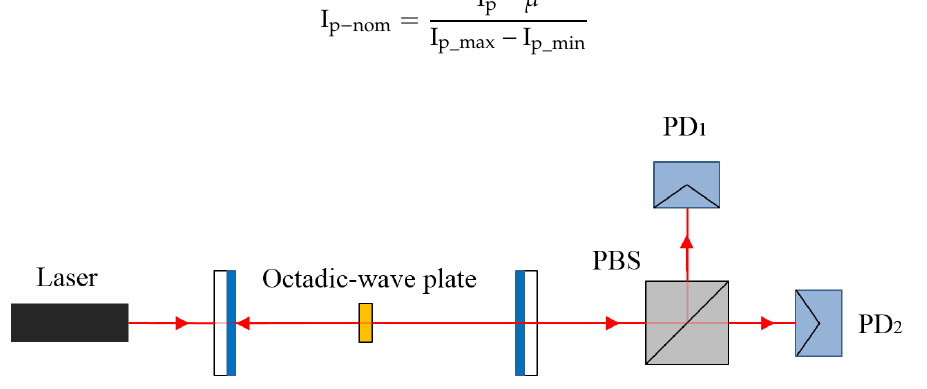
Figure 2. The optical arrangement of polarized Fabry–Pérot interferometer. PBS, polarizing beam splitter; PD, photodiode.